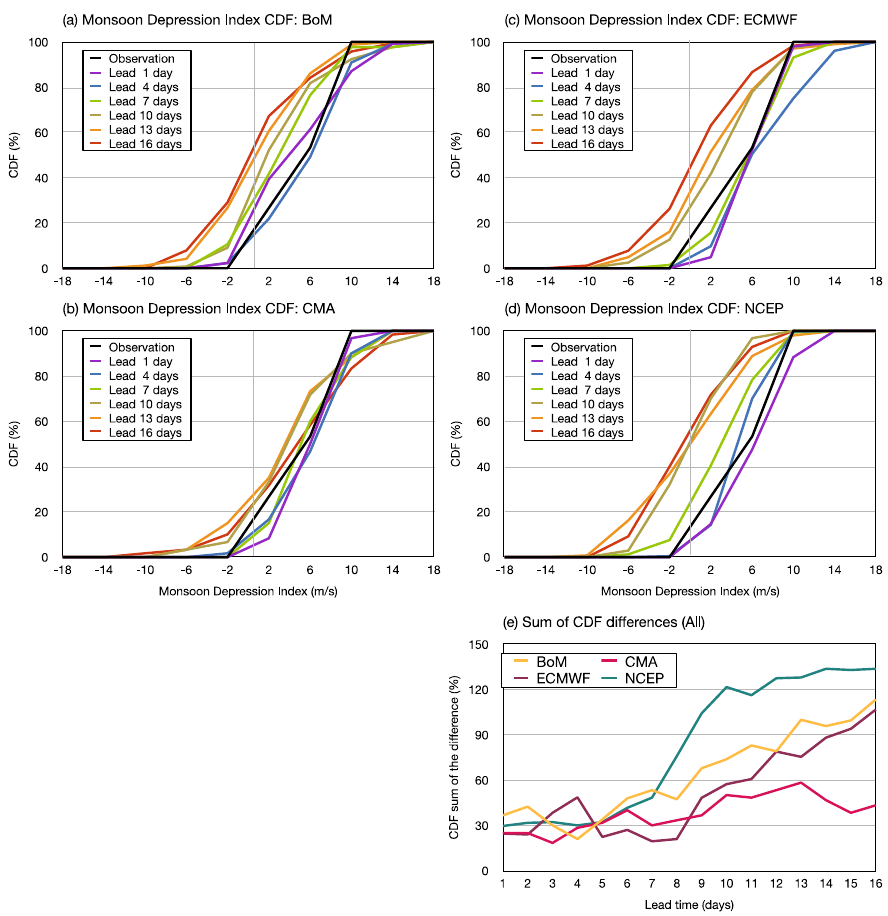
Figure 8. The sane as Figure 7, but for 2018/19 Box-B SPRE.